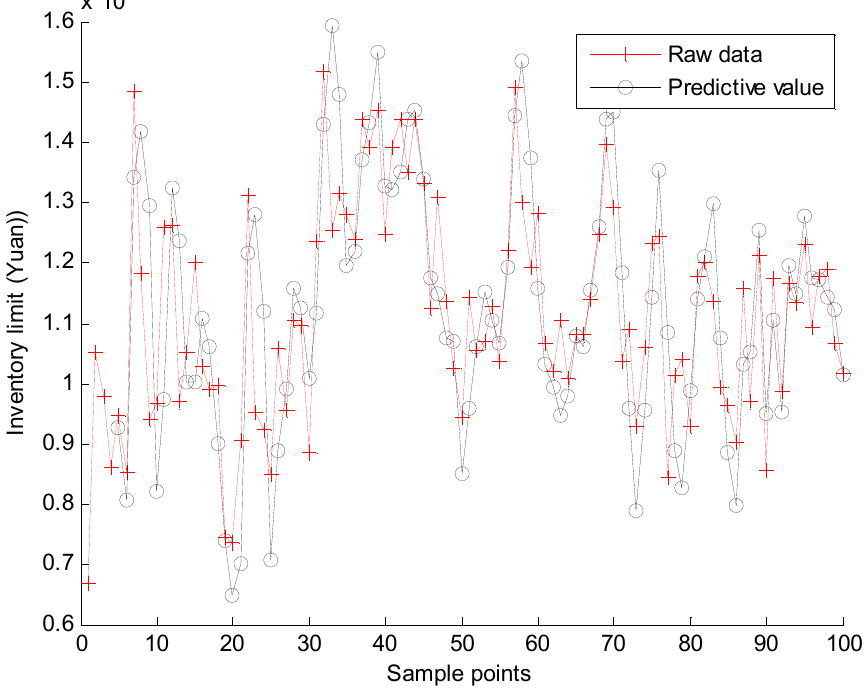
Figure 4. Predictive results of the second moving average method in 2011.